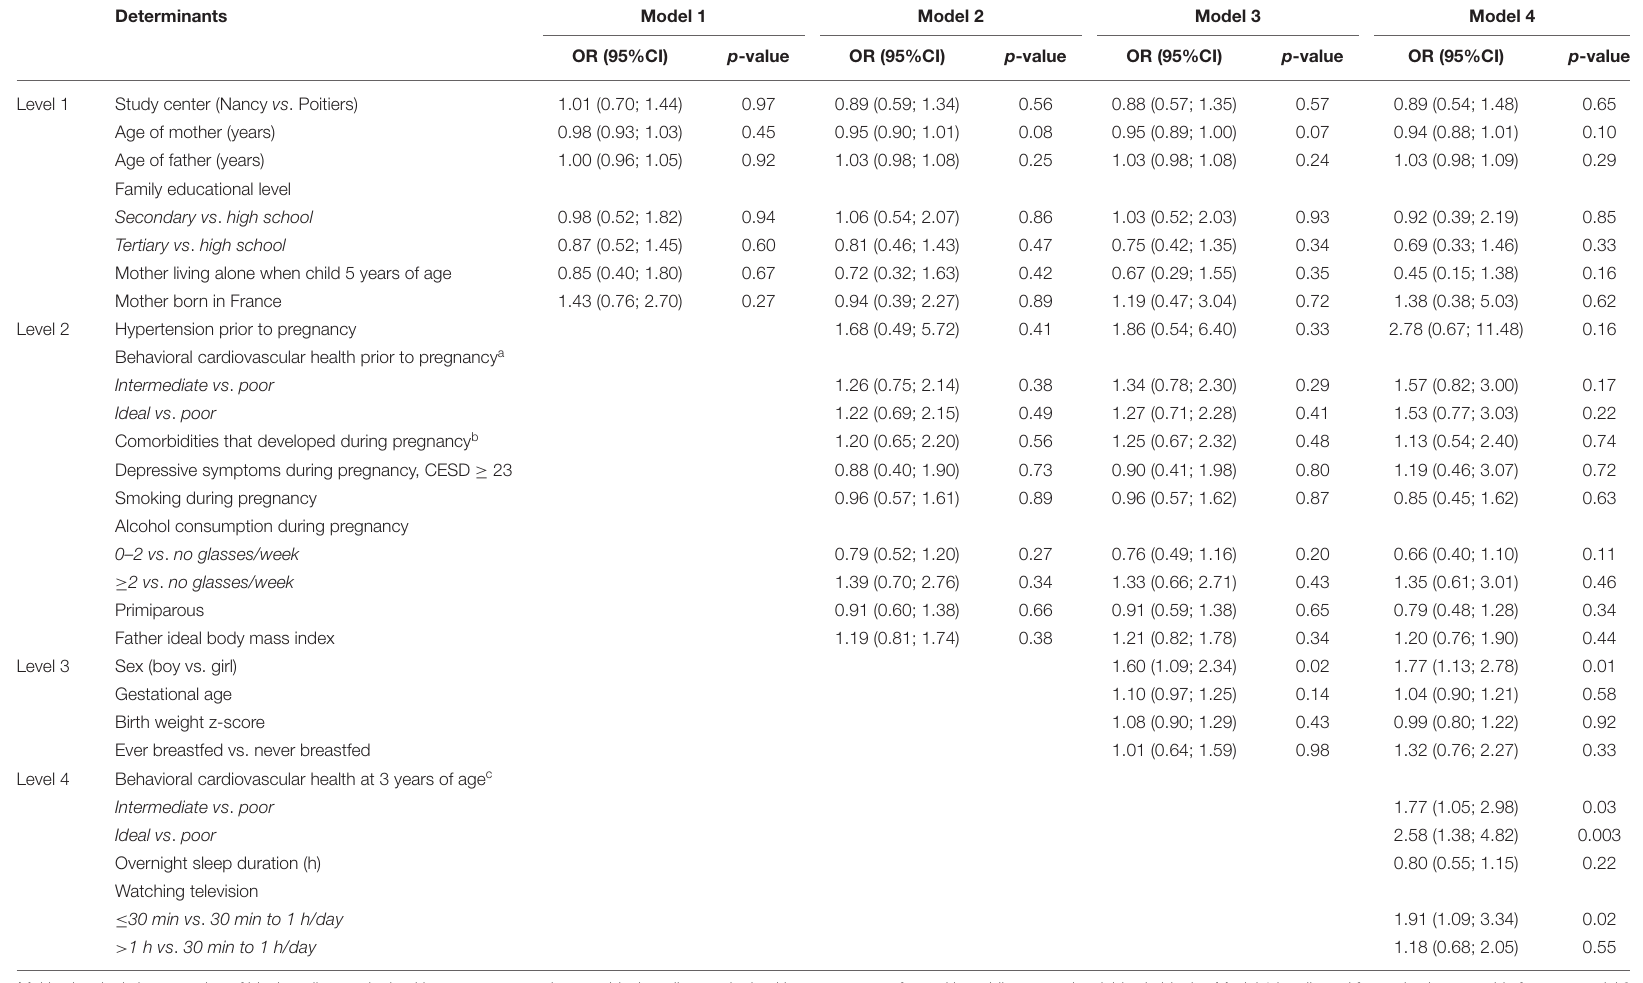
TABLE 2 | Determinants of ideal cardiovascular health in children at 5 years of age.